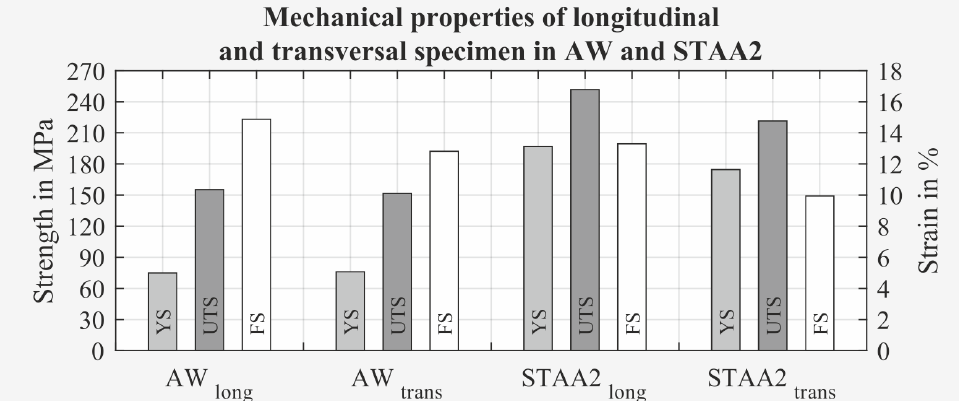
Figure 9. The mechanical properties of longitudinal and transversal specimens in AW and STAA2.